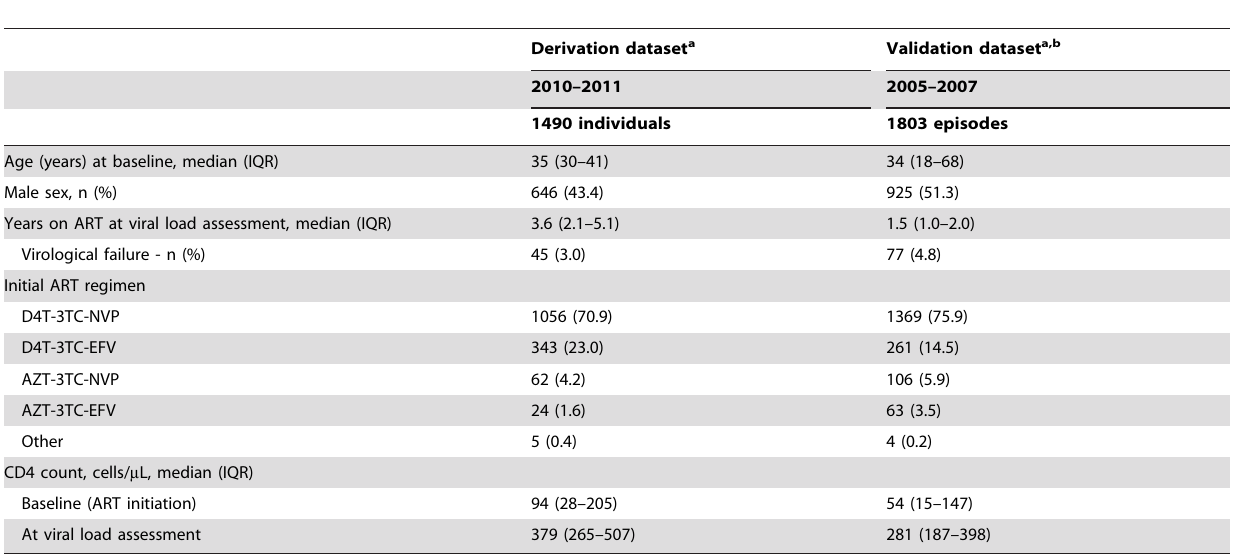
Table 1. Datasets used for the development and validation of the simplified prediction score to identify virological failure.